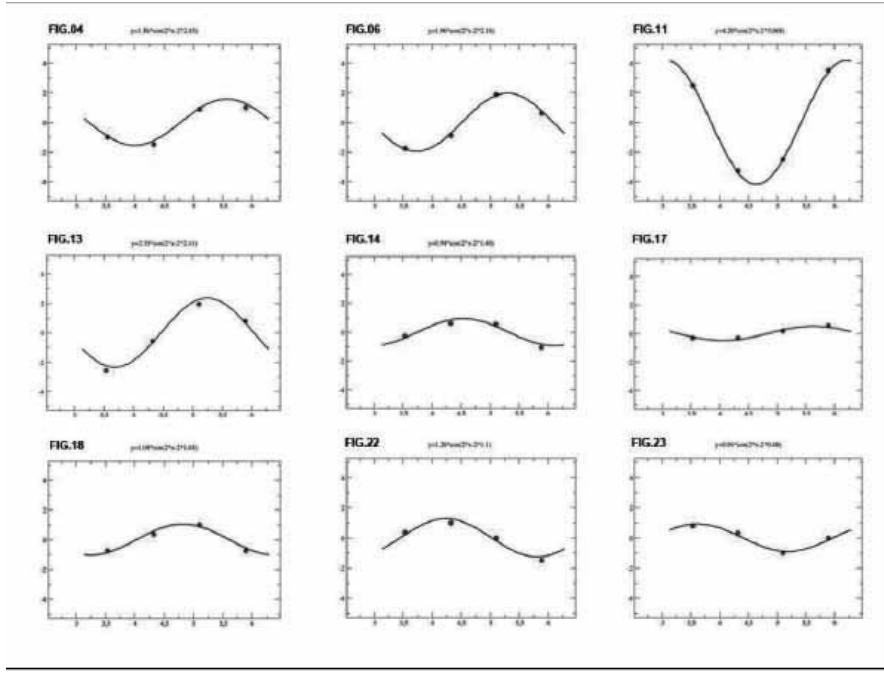
Figure 5. Some second-harmonic fits to Joos’ data. The figure is taken from [40].